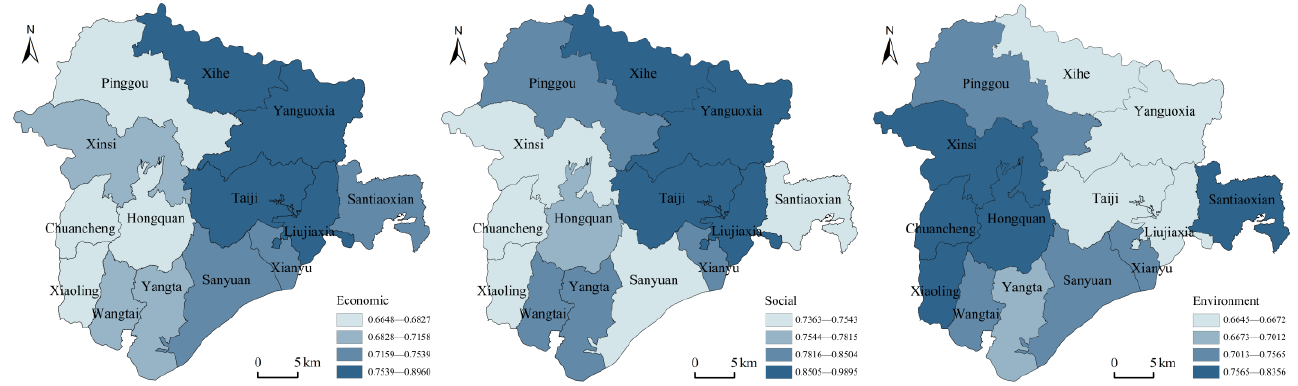
Figure 3. Evaluation results of sustainable livelihood subsystem of ecological migration area in Liujiaxia Reservoir area.